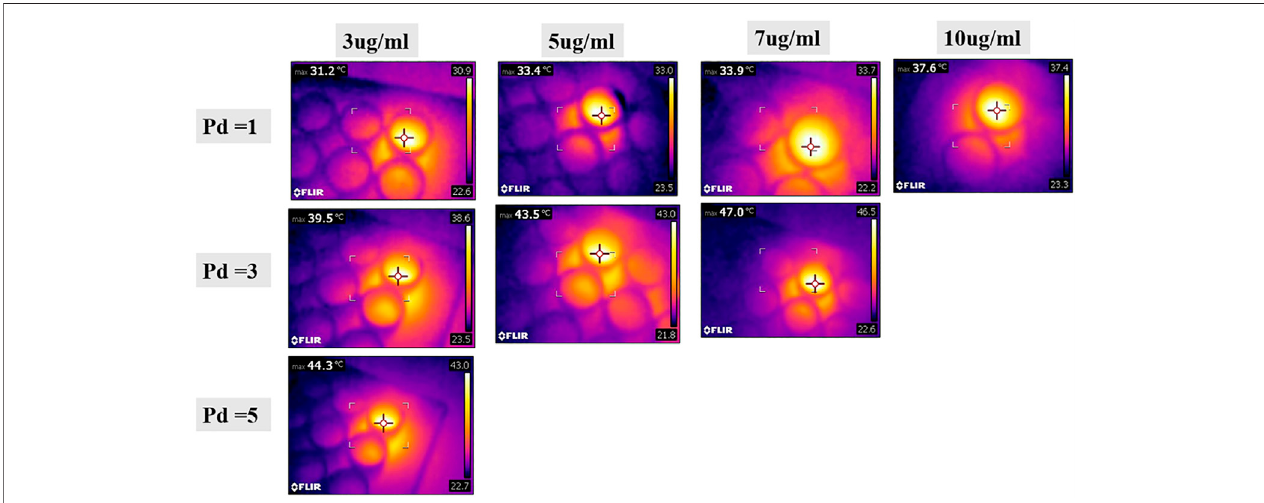
FIGURE 11 | Temperature measurements obtained when MXene with different dilutions (diluted with PBS) is exposed to laser with different PDs. These measurements were matched with temperature measurement obtained when the cells are treated with MXene, to approximately assess the concentration of MXene internalized by the cells (3